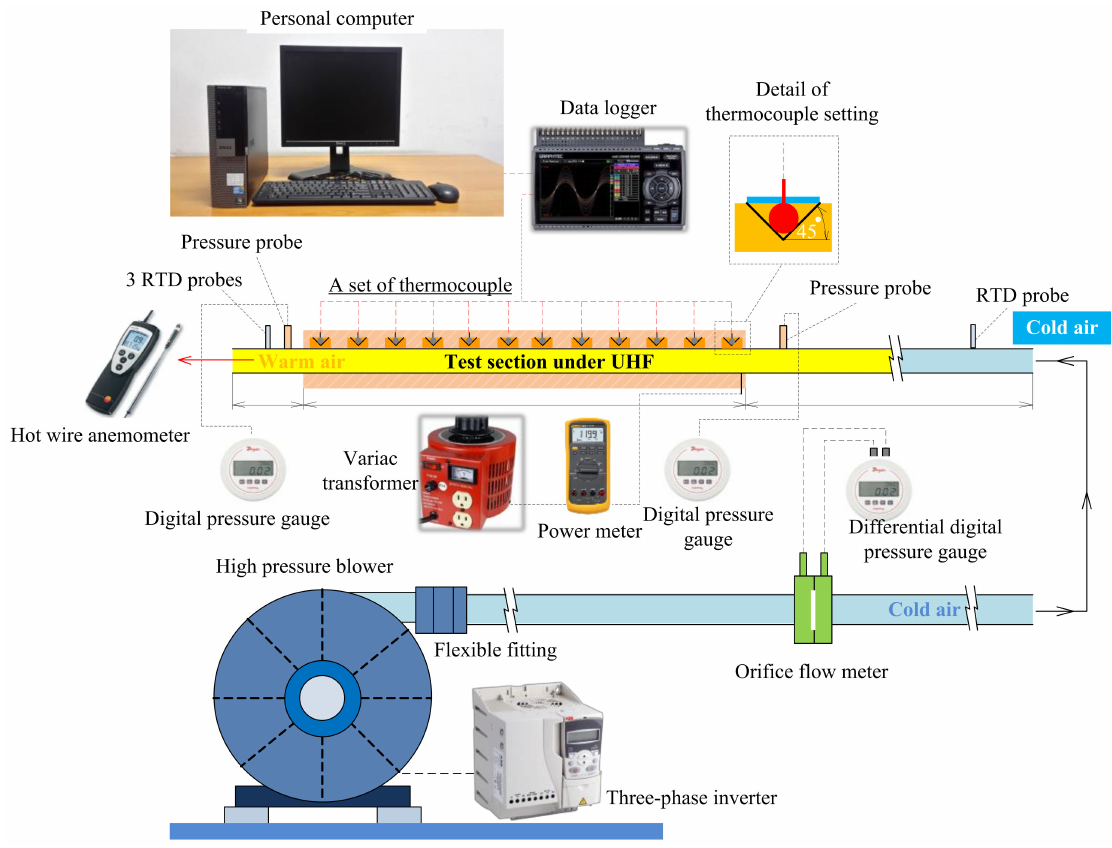
Figure 3. Experimental